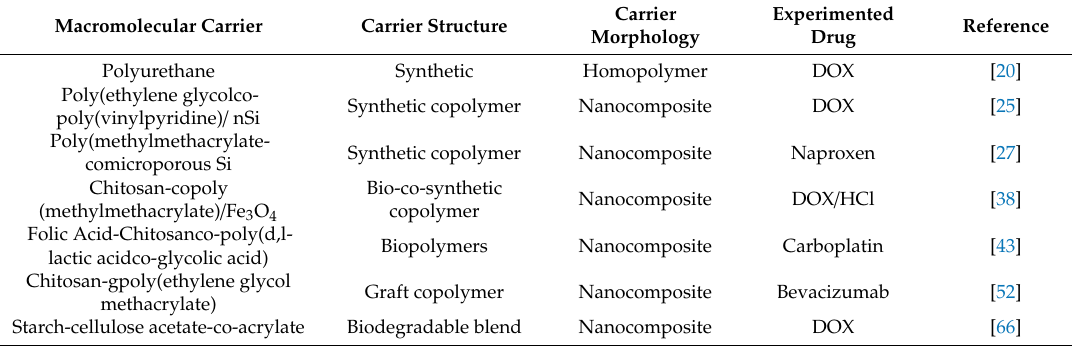
Table 1. Carriers and drugs used in di ff erent